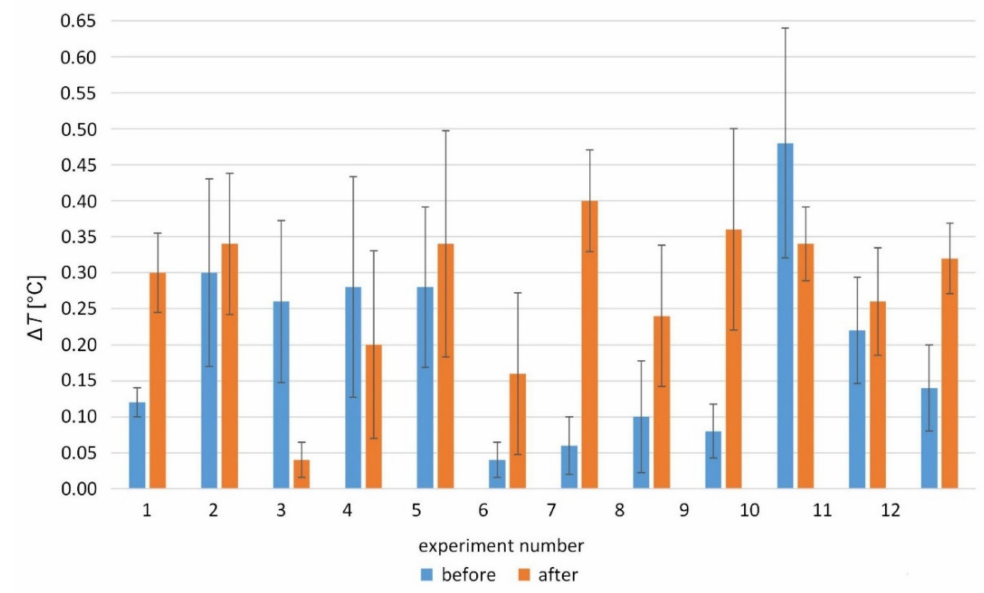
Figure 12. The average YPD temperature difference between control and exposed samples before and after the